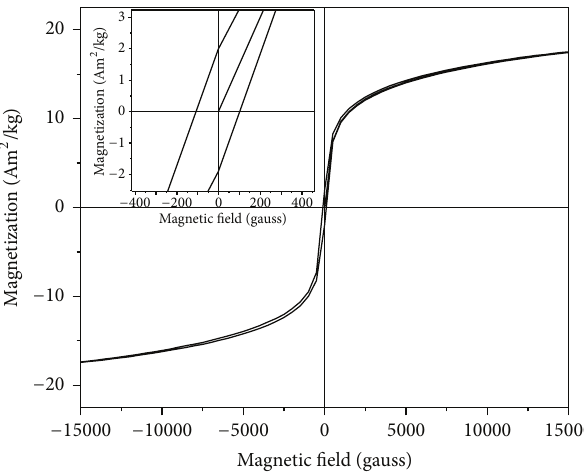
Figure 3: Hysteresis loop of 𝛼 -Fe 2 O 3 nanopowder.